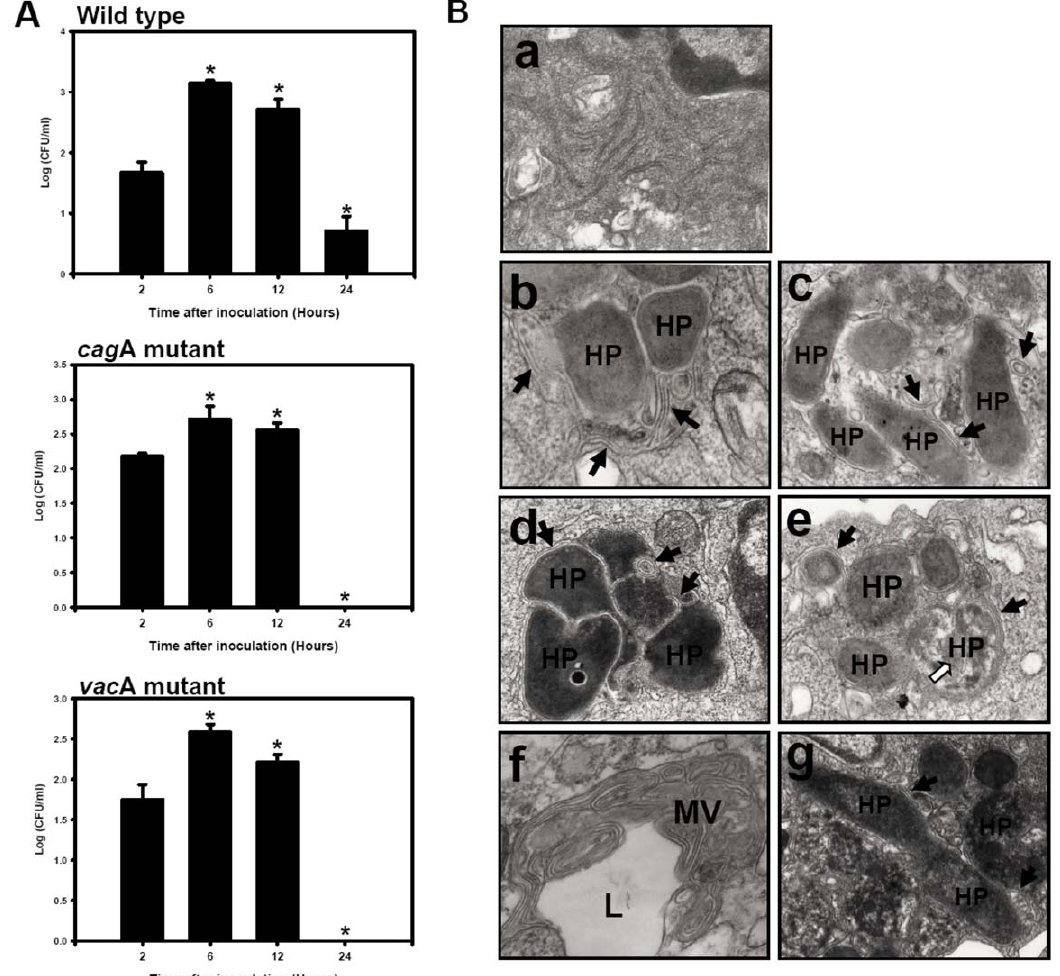
Figure 1. Multiplication of H.pylori in BMDC cells. (A) Multiplication of H. pylori in BMDCs. BMDCs infected with HP238 wild type, VacA or CagA mutants at m.o.i.=10 for 2, 6, 12 and 24 h were lysed and intracellular bacteria were quantified at different time points after inoculation. The recovered viable H. pylori were determined as CFU on CDC plate. (B) Ultrastructural alterations in H. pylori -infected BMDCs. At 2 h (b, c), 6 h (d, g), 12 h (f), and 24 h (e) post infection, infected cells were collected for EM examination. (a) shows the mock samples without H. pylori infection. (g) shows the dividing bacteria at 6 h p.i. ‘HP’ indicates the location of H. pylori within BMDCs. Closed arrows indicate the double-layer structure whereas opened arrows indicate digested bacteria. (f) shows the multivesicular structure (MV) and lysosome (L) at 12 h p.i. * p , 0.05 via student